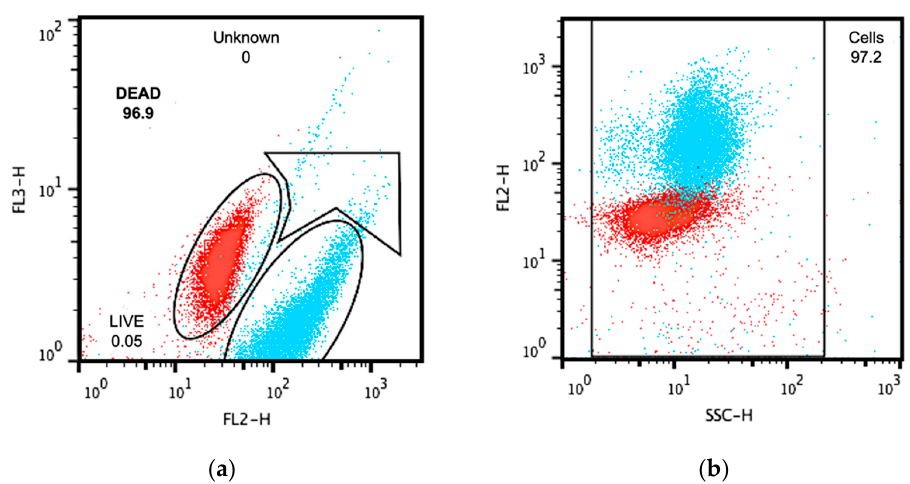
Figure 2. Dot plots of detection zones for live (blue) and dead (red) populations. ( a ) Dot plot of gates acquired from the red fluorescence (FL2-H) vs. side scatter or granularity (SSC-H); ( b ) Dot plot of gates acquired from the green fluorescence (FL3-H) vs. red fluorescence (FL2-H). Numbers represent the cell percentage with respect to the total acquired events.